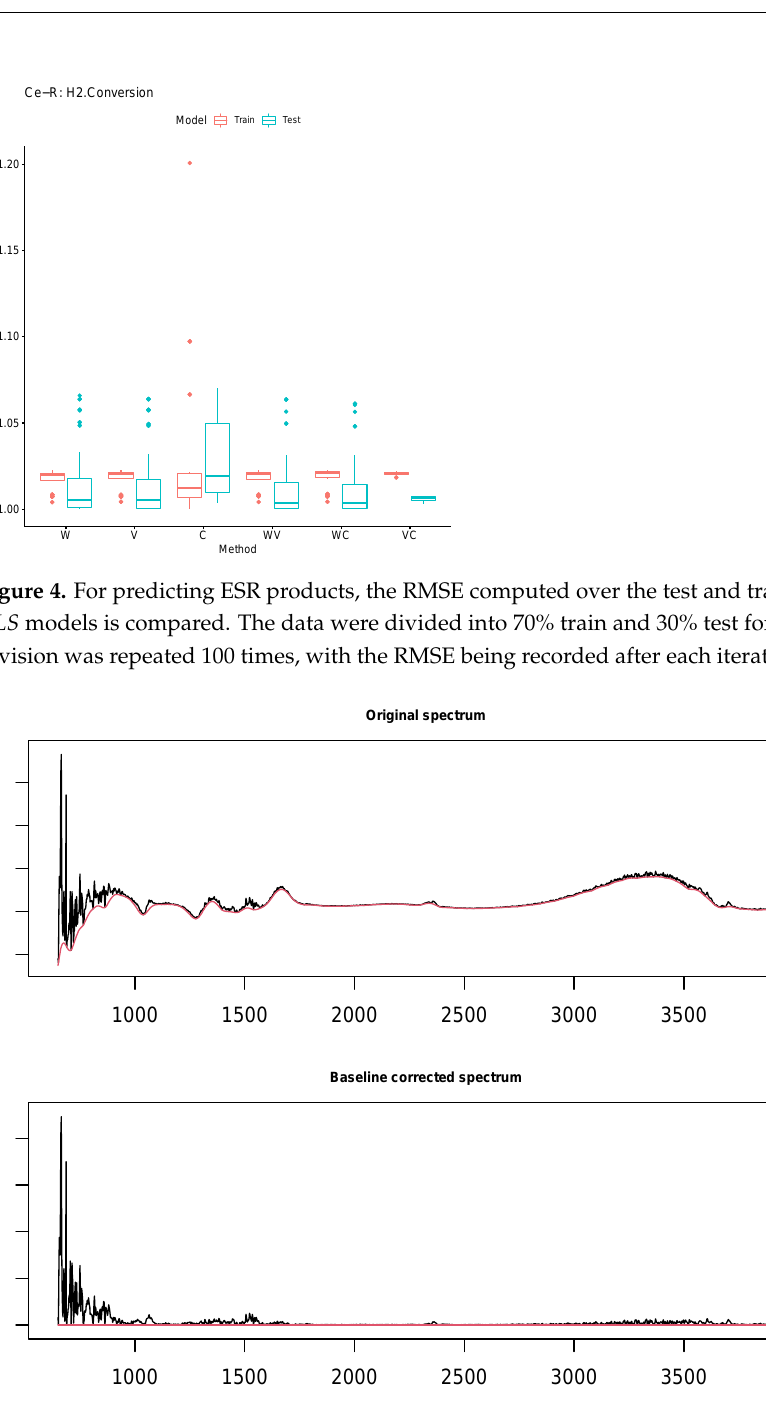
Figure 5. The FITR spectra were adjusted for baseline correction. The baseline correction is carried out of spectra reference to variability in response, since we have modeled 9 responses, i.e., ESR product hence we got 9 baseline correction used in their respective models. The baseline correction presented here is for the model CO conservation with rod morphology. The original and corrected FTIR spectra is presented here for